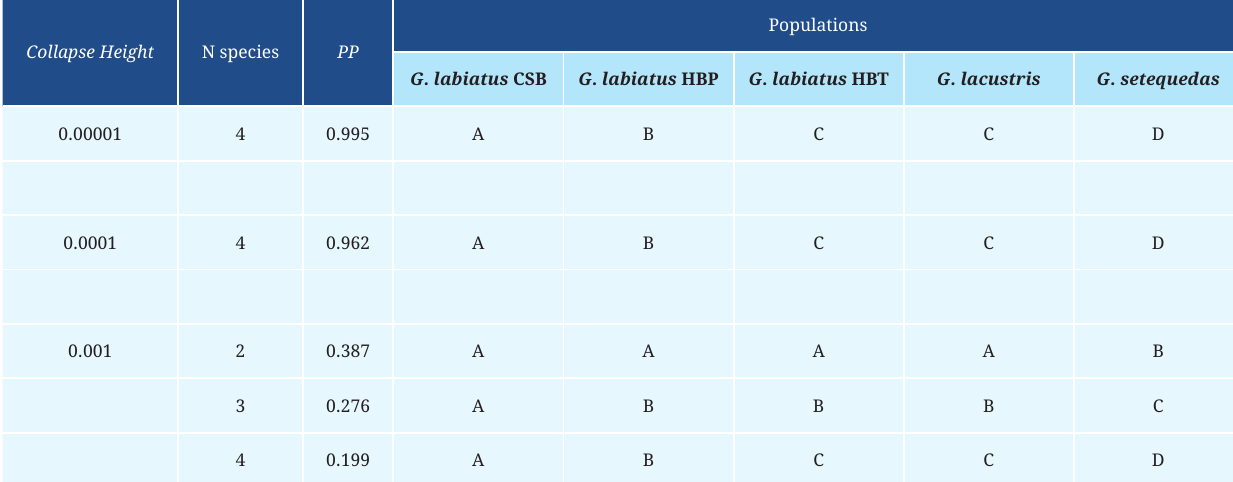
FIGURE 5 | Evolutionary relationship between populations of Gymnogeophagus based on mitochondrial haplotypes. The x-axis scale corresponds to millions of years. The values above the nodes correspond to the posterior probability of each clade. The bar associated with each node represents the 95% credibility interval for the date of the common ancestor. The colors represent the analyzed populations, according to the legend. TABLE 3 | Delimitation of candidate species under a coalescent criterion. N species = number of candidate species; PP = Posterior probability for a specific arrangement, considering the number of species and which populations make up each group. The letters assigned to each population correspond to all candidate species suggested in the analysis. For a collapse height value of 0.001, three alternative arrangements were contained within the 95% credibility range. Note that in all arrangements Gymnogeophagus labiatus HBT and G. lacustris were assigned as the same candidate